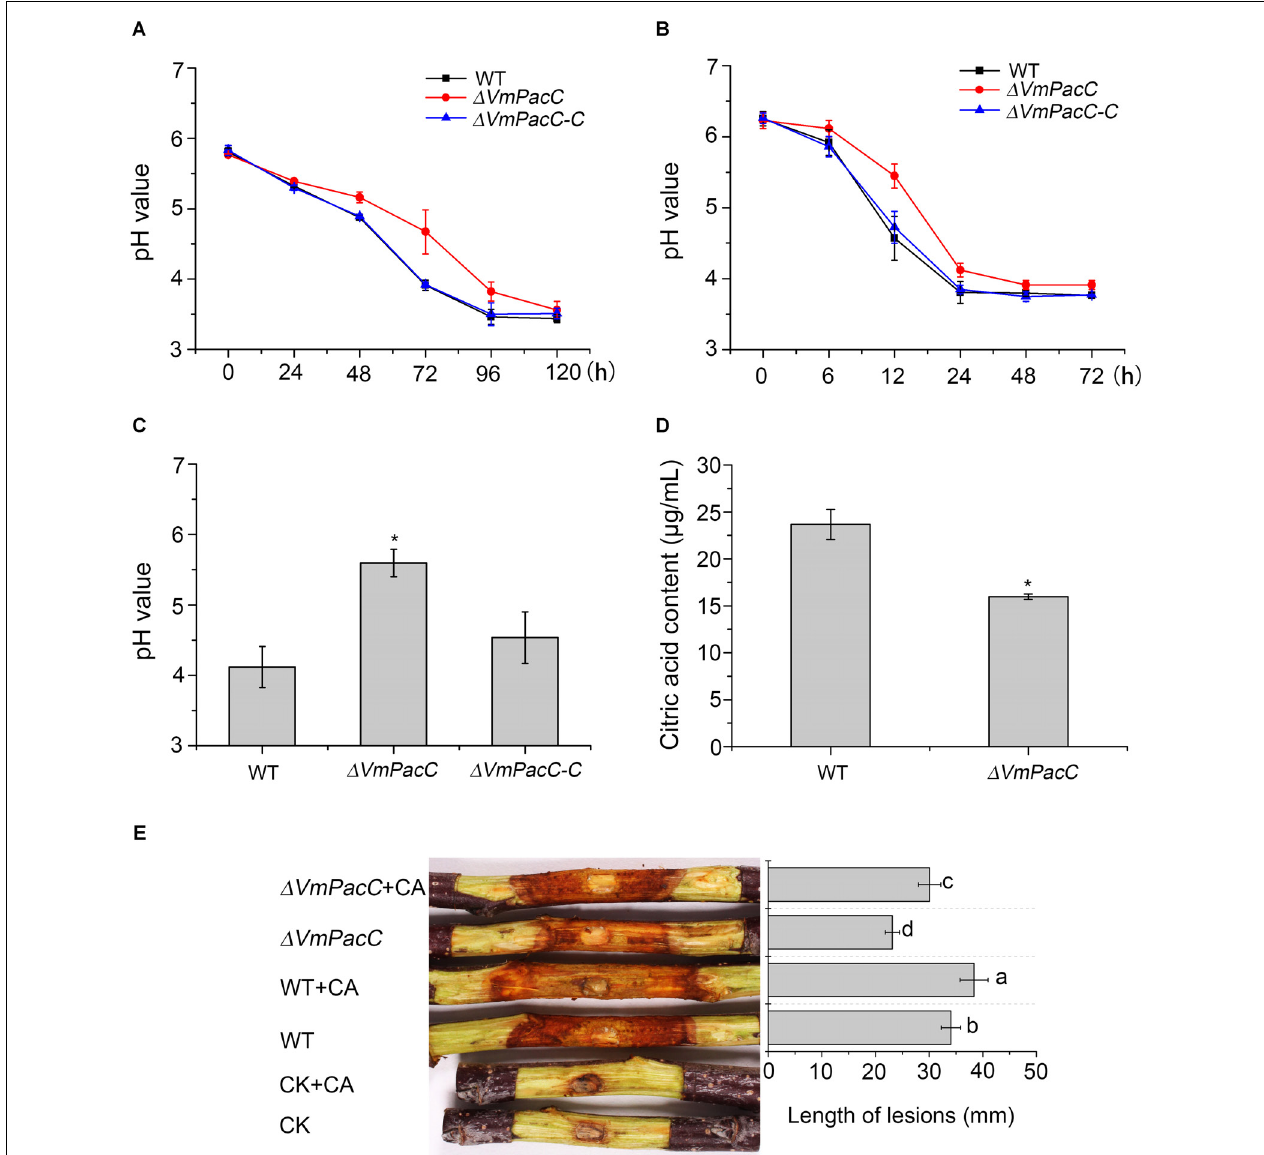
FIGURE 7 | Valsa mali modulates its environmental pH. (A) Decrease in pH value during growth of different strains for 120 h. (B) pH values at the inoculated sites in the apple tree bark. (C) pH values at the lesion borders of the apple tree bark. (D) Citric acid production in wild-type and VmPacC deletion mutant strains grown in PDB determined by high-performance liquid chromatography (HPLC). The experiments were repeated three times. The asterisk represents a statistically significant difference compared to wild-type. (E) Virulence assays performed on twigs with wild-type and deletion mutant strains using citric acid (CA). The length of lesions was measured at 9 days post-inoculation. The experiments were repeated three times. Different letters represent a significant difference ( P <